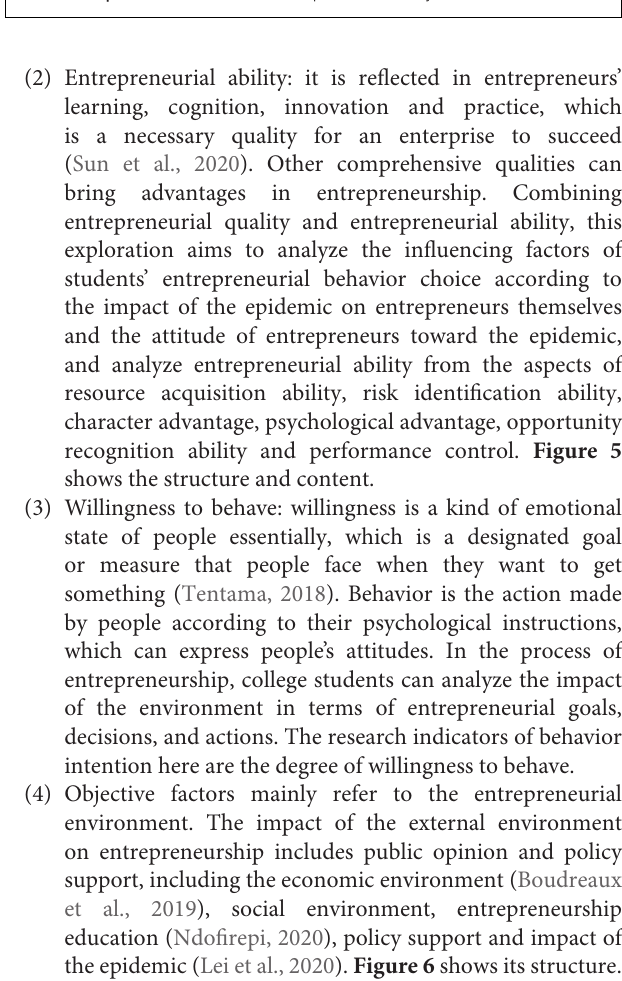
FIGURE 3 | The influencing factors of entrepreneurial choice.